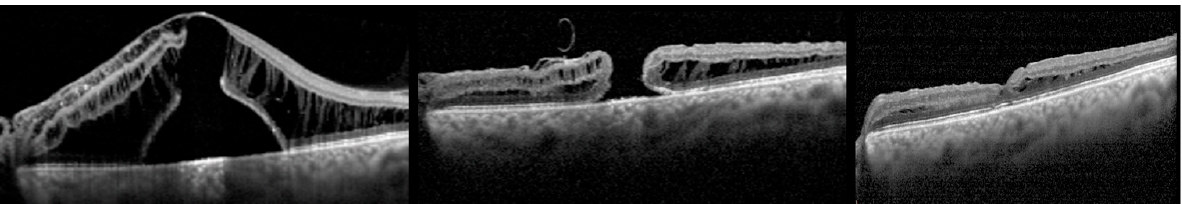
Figure 3. Case 3: An optic disc pit maculopathy with intraretinal fluid involving inner and outer retinal layers and subretinal fluid ( left ). A secondary full-thickness refractory macular hole after a primary 25-G pars plana vitrectomy (PPV) with internal limiting membrane peeling and foveal spar- ing ( middle ). The FTMH was closed at 3 months after the secondary PPV with autologous platelet- rich plasma and gas tamponade ( right ).